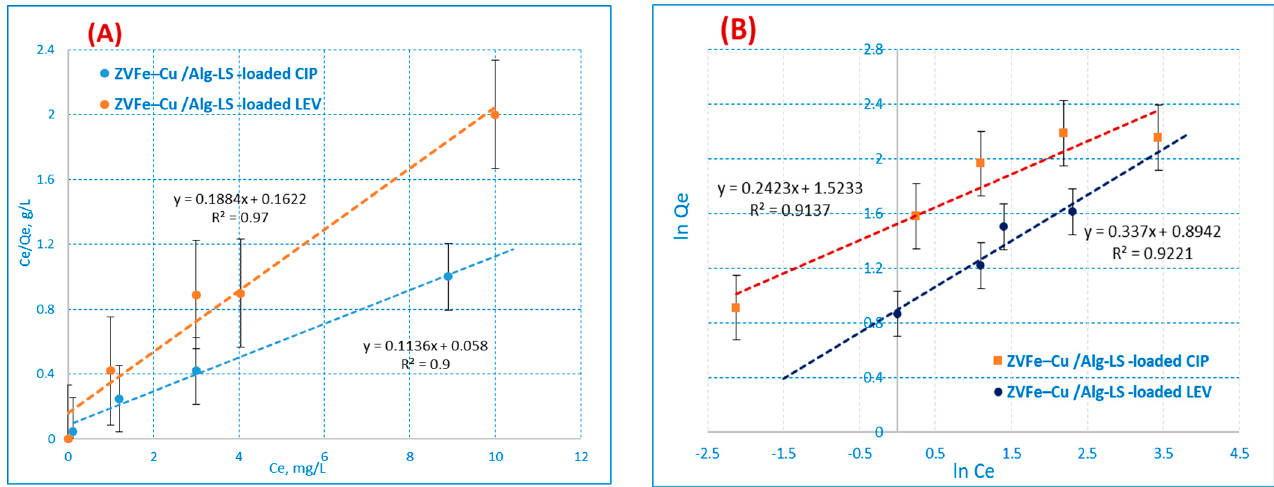
Figure 8. ( A ) Langmuir ( B ) Freundlich adsorption isotherm.